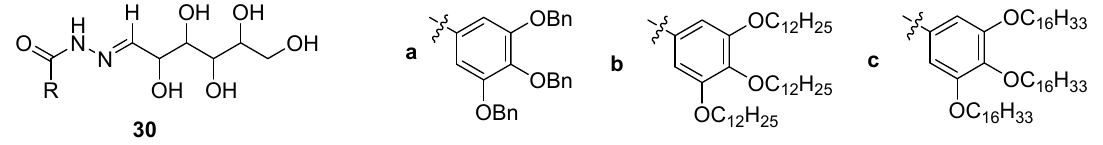
a glass slide covered with a hydrophobic polycarbonate membrane [67].